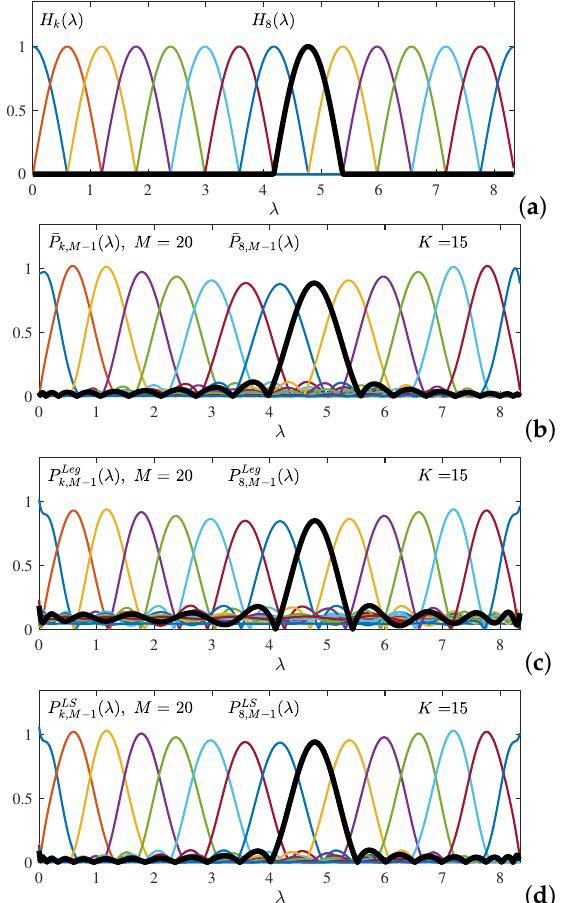
Figure 15. Spectral bandpass transfer functions used for calculation of the LGFT and their polynomial approximations. ( a ) Spectral functions of the Hann form with K = 15. ( b ) Approximation of spectral transfer functions based on Chebyshev polynomial with M = 20. ( c ) Legendre-polynomial-based approximations of spectral transfer functions with M = 20. ( d ) Least squares approximation of spectral transfer functions with M = 20. For convenience, function H 8 ( λ ) is designated with a thick black line on each panel.